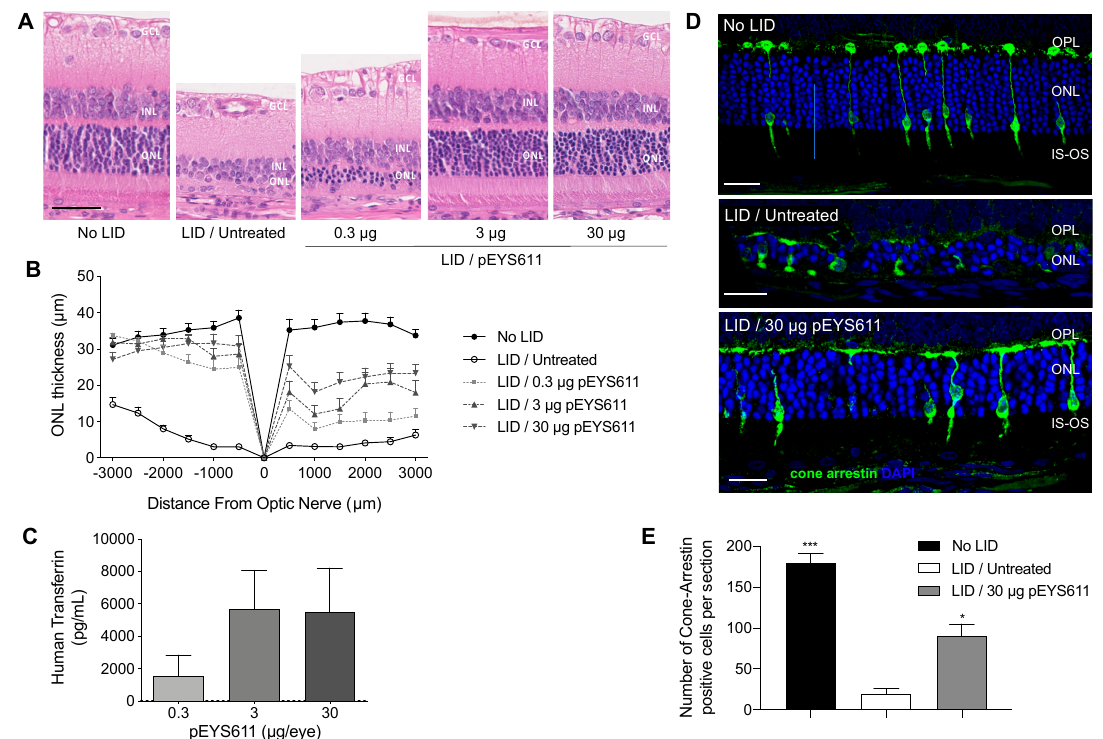
Figure 3. Dose-dependent effects of pEYS611 administration in the rat light-induced damage (LID) model. Rats received a single ciliary muscle electrotransfection of pEYS611 at the dose of 0.3, 3, or 30 µg/eye on day (-) 3 (D-3) or left untreated ( n = 8 animals/group). Except for the unexposed animals (no LID), retinal degeneration was induced on D0 by 24 h of bright light exposure (6500 lux). Dark- and light-adapted electroretinography (ERG) responses were recorded simultaneously from both eyes on D8. Following ERG recordings, animals were sacrificed for analysis of human TF levels in ocular fluids and histological evaluations. ( A ) Representative images of retina section (superior pole) stained with hematoxylin eosin. Scale bar, 50 µm. ( B ) ONL thickness was measured every 500 µm from the optic nerve (0) to the inferior ( − ) and superior (+) poles of the retina. Compared with no LID control animals, the ONL of LID/untreated animals was thinner. Treatment with pEYS611 resulted in a dose-dependent preservation of the ONL, correlating with human TF levels measured in ocular fluids ( C ). ( D ) Representative images of cone-arrestin staining at a distance of 1500–2000 µm from the optic nerve in the superior part of the retina (4.6-diamidino-2-phenylindole (DAPI) in blue/cone arrestin in green). Scale bar, 25 µm. ( E ) The number of cone-arrestin-positive cells per retinal section was significantly higher in LID/pEYS611-treated animals compared to LID/untreated rats. All values are presented as mean ± sem. * p < 0.05; *** p < 0.001 using Dunn’s multiple comparisons test versus LID/untreated group. IS, inner segment; ONL, outer nuclear layer; OPL, outer plexiform layer; OS, outer segment.